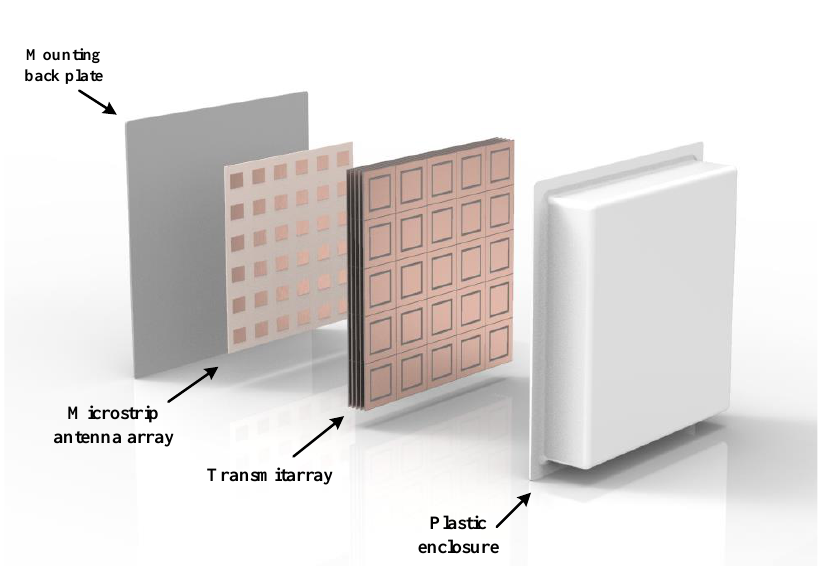
Figure 1. Overall schematic of the proposed 5G antenna